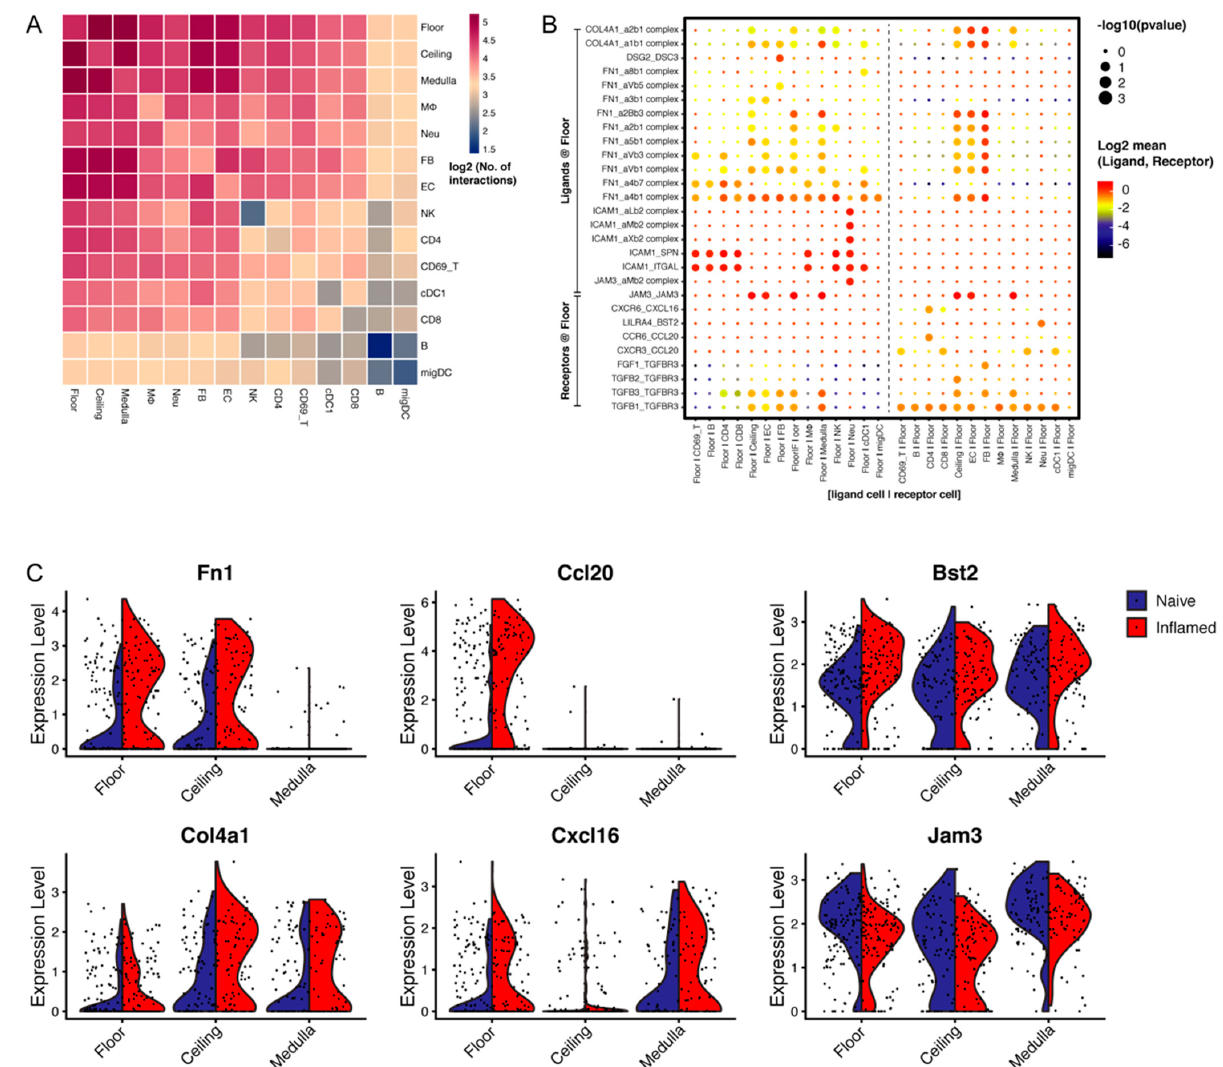
Figure 4. Identification of potential intercellular interactions between LN LECs and other LN cells. ( A ) Heatmap depicting the predicted interactions among different cell populations in naïve LN. The color scale indicates log2 (number of interactions). ( B ) Dot plot of selected interaction pairs involving ligand or receptor molecules that are differentially regulated in floor LECs under inflammation condition over the control. Color gradient is defined by the log2-transformed average expression of ligand and receptor molecules in the interacting cell types, including B cells (B), CD8 T cells, macrophages (M Φ ), conventional dendritic cells (cDC1), CD69 + T cells (CD69_T), migratory dendritic cells (migDC), NK cells, CD4 T cells, endothelial cells (EC), fibroblasts (FB), and neutrophils (Neu). The circle size denotes − log 10 ( p value). ( C ) Example genes that are up- or down- regulated in floor LECs upon imiquimod inflammation. 3.6. Imiquimod-Induced Inflammation Elicits Many Transcriptional Changes also Observed after Cutaneous Oxazolone Challenge Repeated imiquimod treatment leads to a psoriasis-like skin inflammation, and the experiments presented here were performed at a time when inflammation had been well established (7 days). A recent scRNA-seq study, which exploited a more acute (48 h) in- flammation model using topical oxazolone, illustrated rapid transcriptomic remodeling of LN LECs [10]. Oxazolone as a hapten leads to contact hypersensitivity, eliciting an adaptive immune response with generation of specific T cells [49]. To define the similari- ties as well as differences in the LN LEC transcriptomes under these conditions, we com- pared the responses of the three major LN LEC subsets upon imiquimod or oxazolone